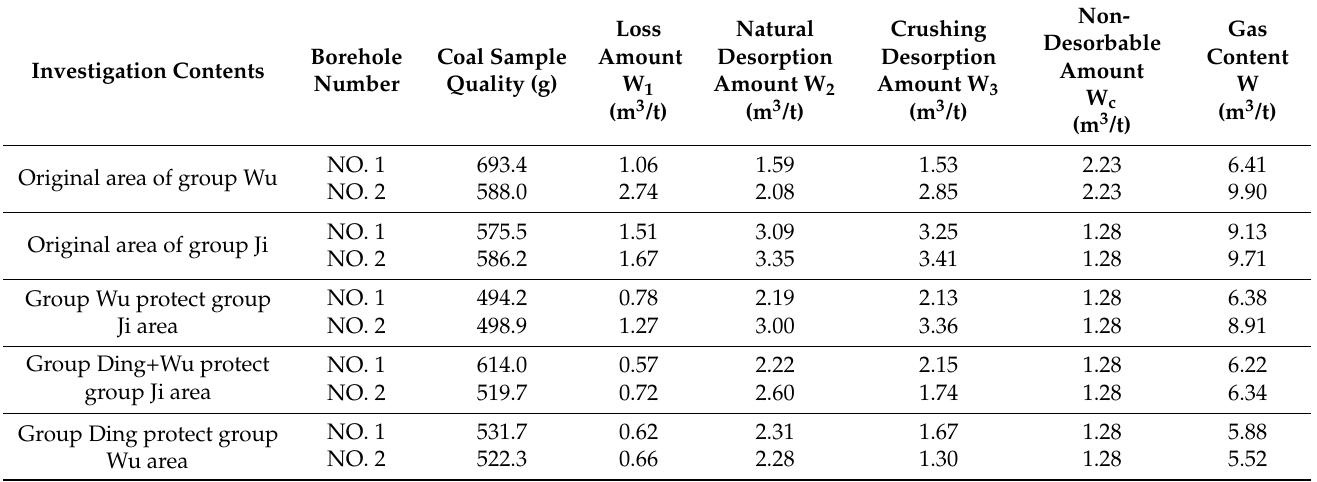
Table 3. Gas content test results.